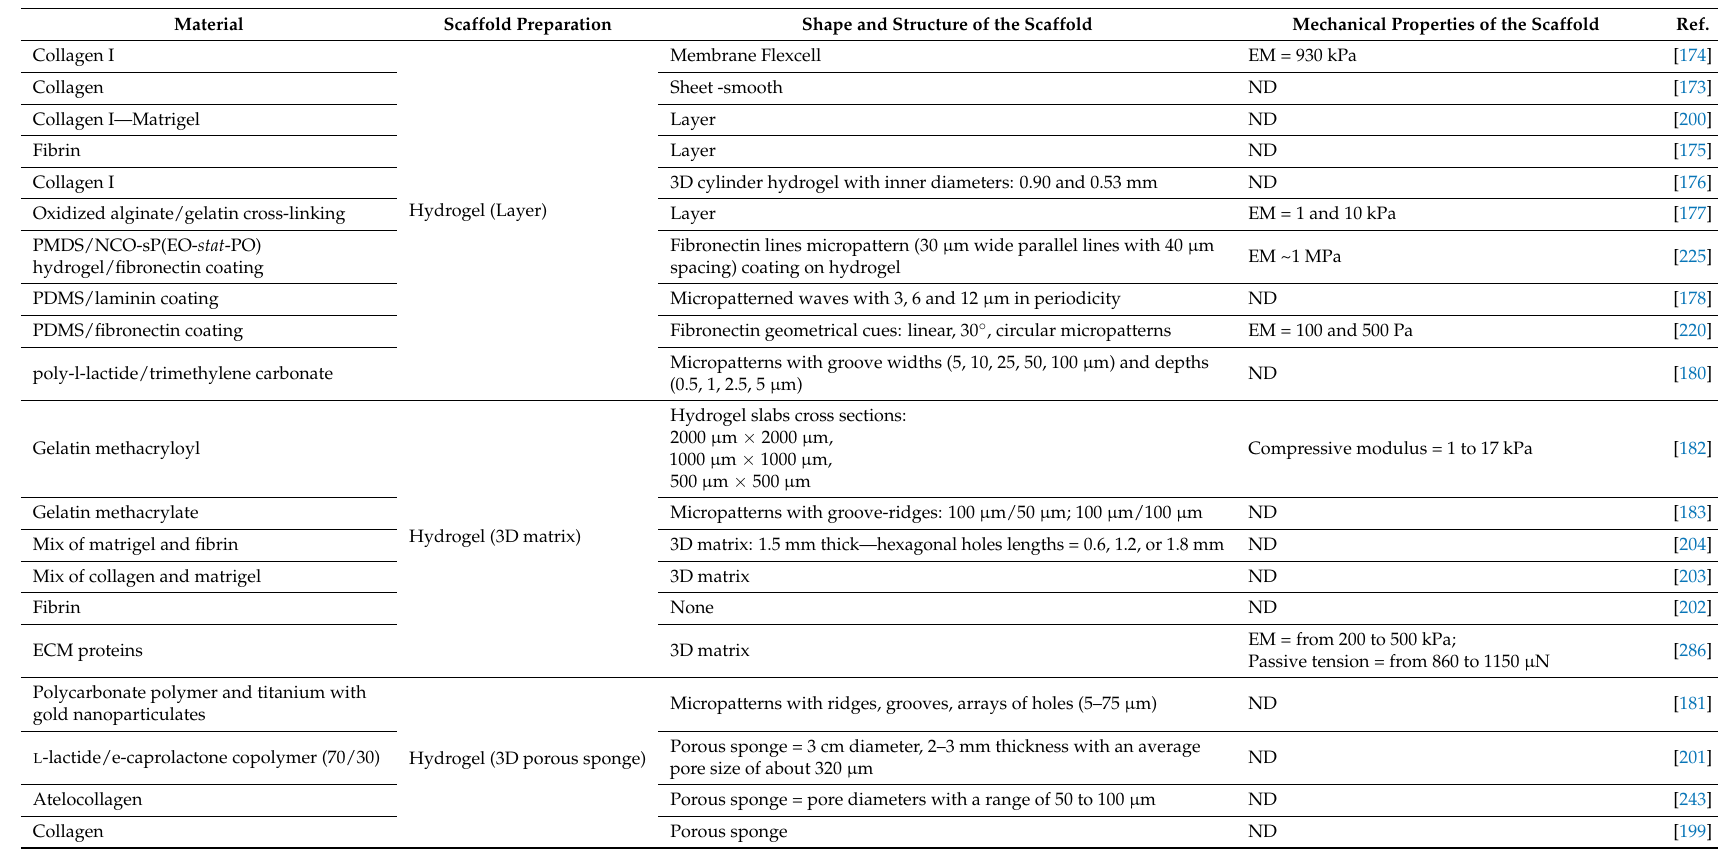
Table 4. Materials characteristic for muscle tissue